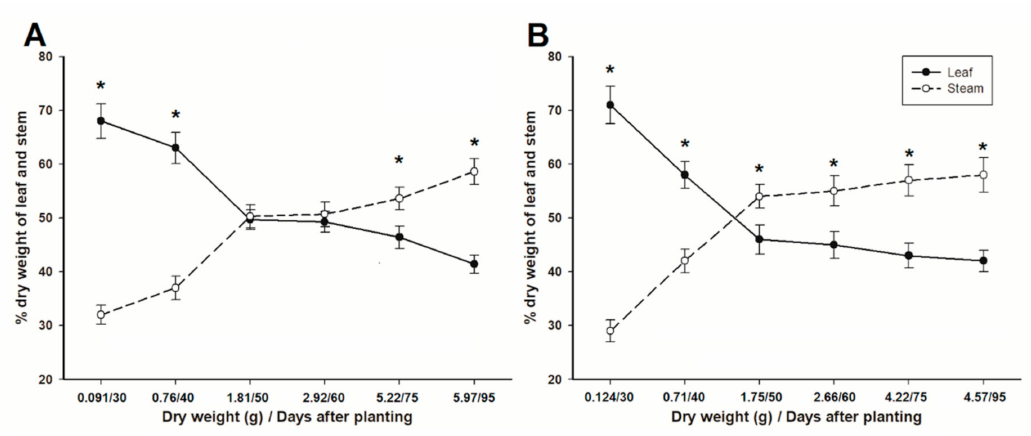
Figure 4. Dry weight ratio of the leaves and stems in imazamox-susceptible ( A ) and -resistant ( B ) wild poinsettia plants. * indicates significant di ff erences at p < 0.05. Vertical bars ± standard error ( n = 30).